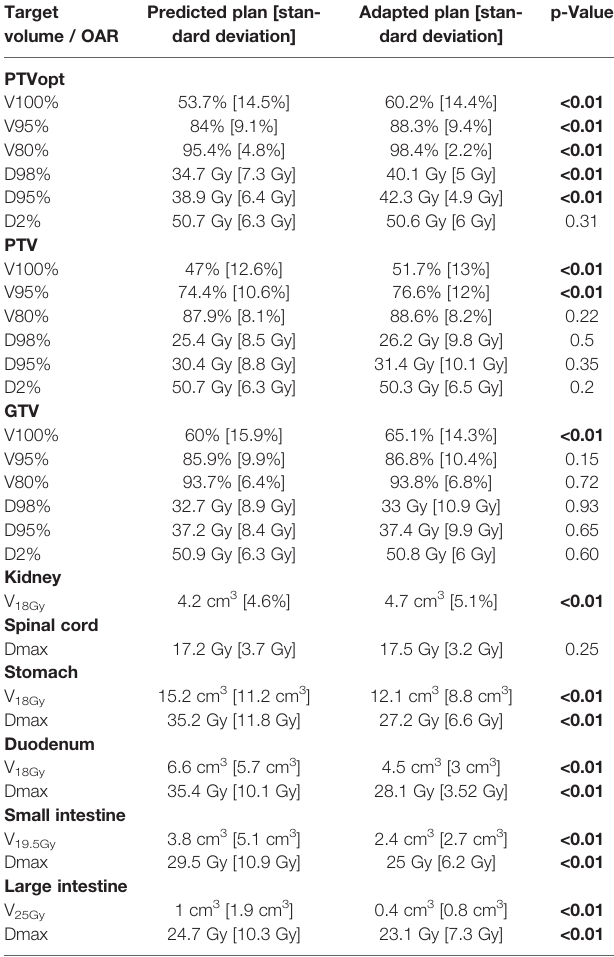
TABLE 4 | Average target volume and OAR dosimetric results for predicted and adapted plans. Target Predicted plan [stan- volume / OAR dard